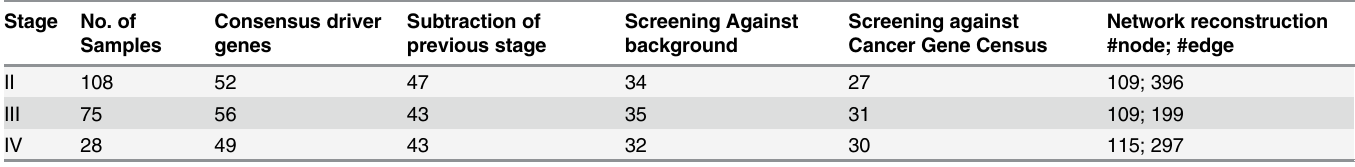
Table 1. From tumor genome-sequencing data to network reconstruction. Stage No. of